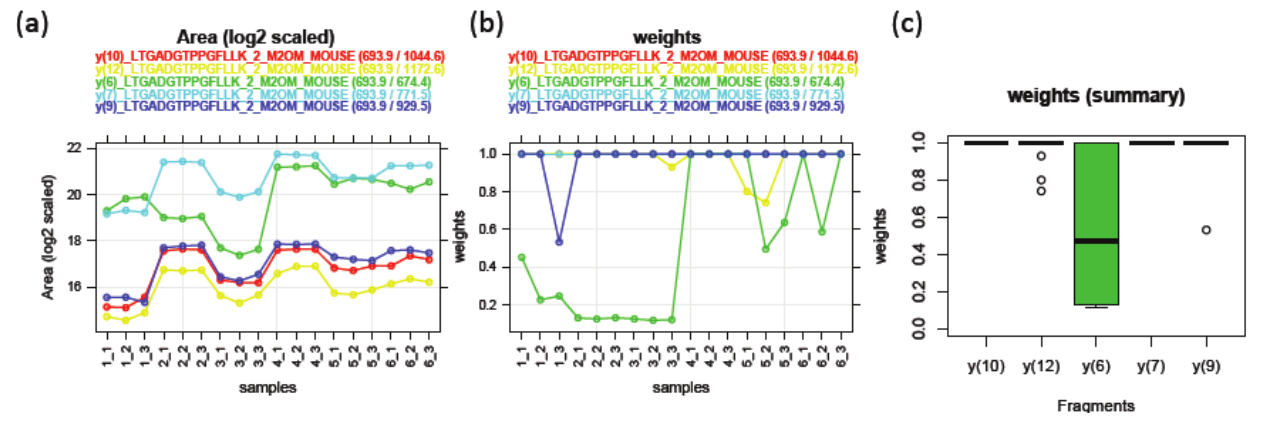
Figure 3. ( a ) Log2 transformed peak areas for five MRM transitions of M2OM peptide LTGADGTPPGFLLK (postsynaptic density (PSD) assay (n = 18)). Peak areas from the same MRM transition are connected with a unique color label. ( b ) Weight as a measure of outlying behavior of each peak. (The weights of y(10), y(12), and y(7) are mostly 1, thus the corresponding red, yellow, and light blue curves are overlapping with the blue curve for y(9).) ( c ) Distribution of weights for each